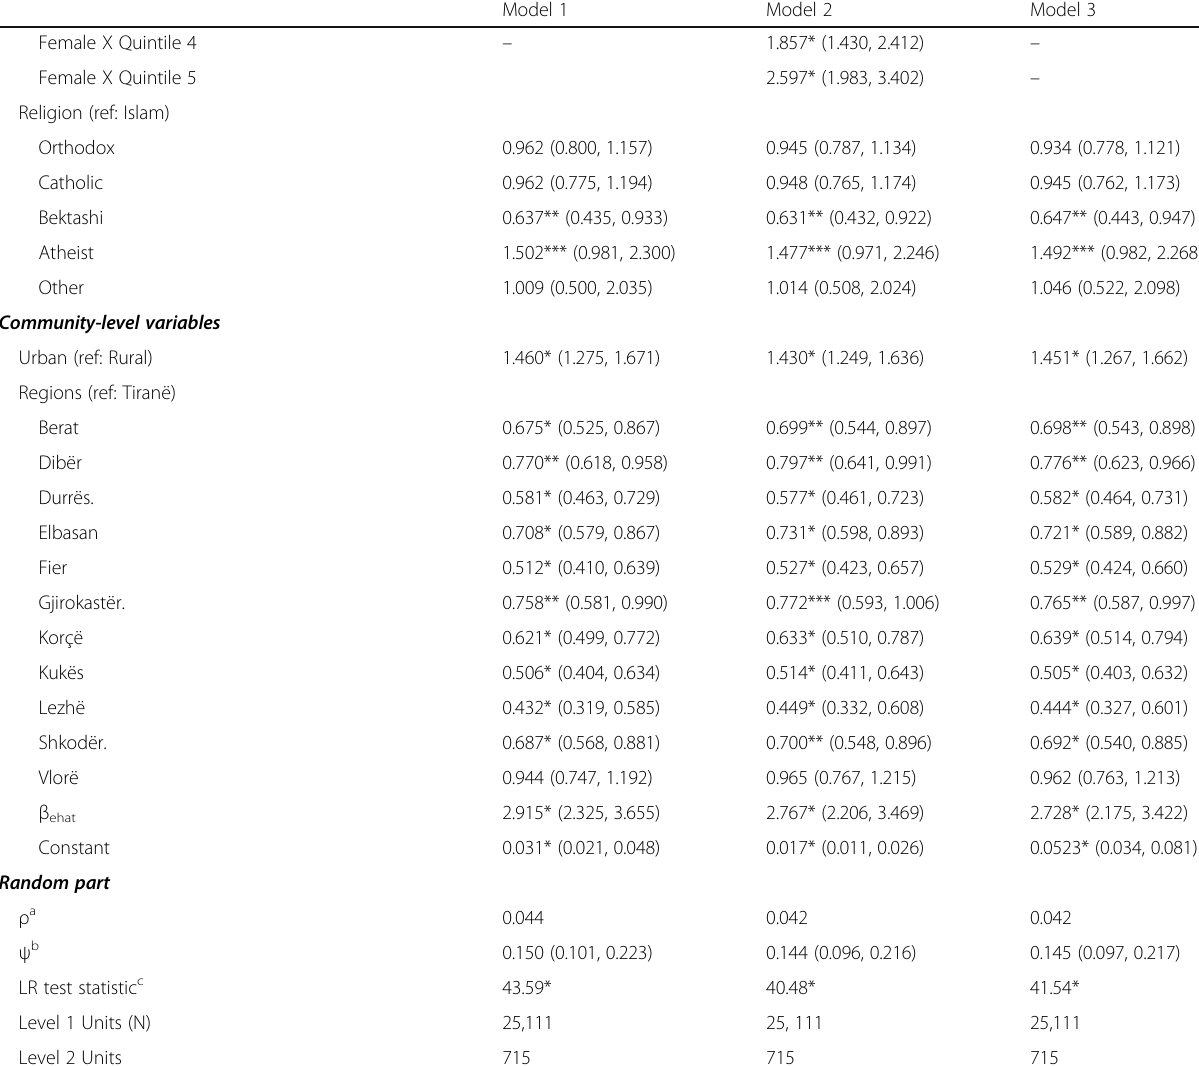
Table 3 Multilevel Logistic Regression results for Smoking Tobacco